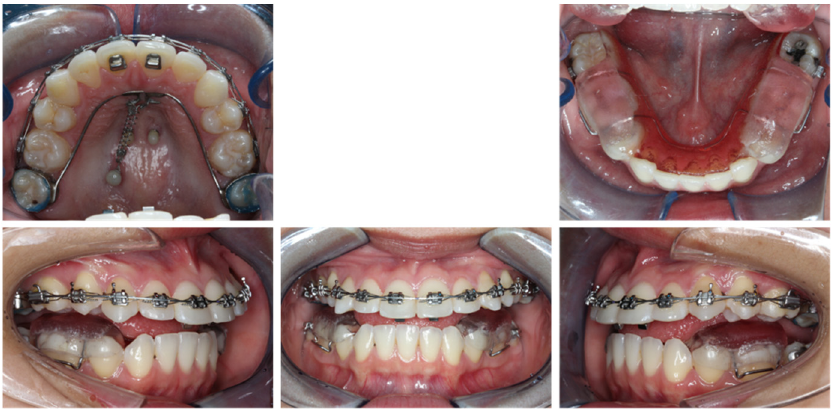
Figure 6. Eight-month progress facial and intraoral photographs.